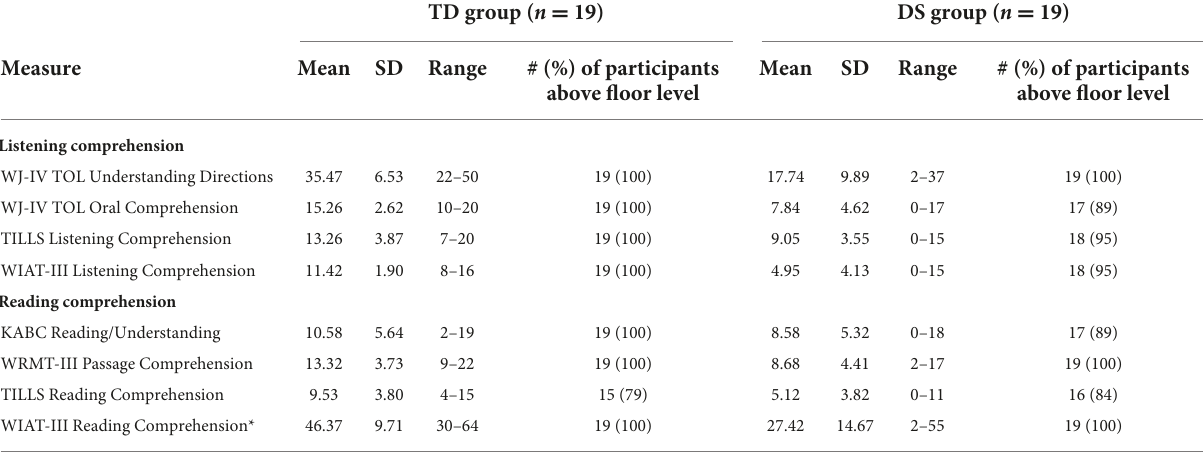
TABLE 5 Participant reading comprehension and listening comprehension raw scores and participants scoring above floor